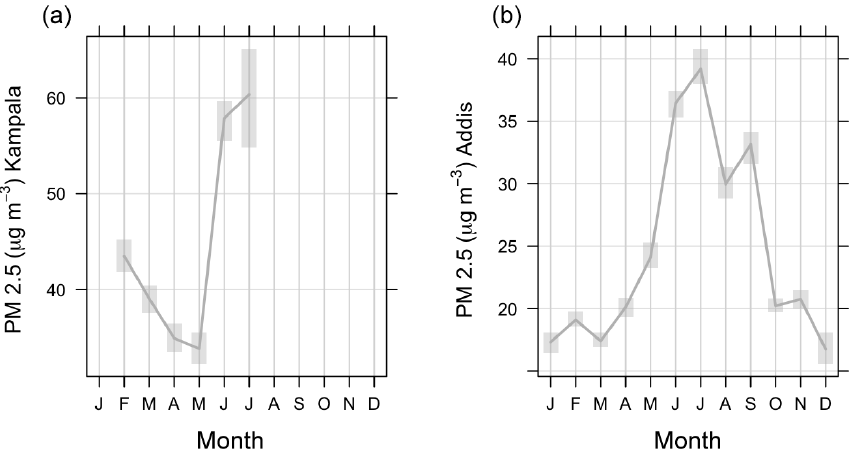
Figure 11. Monthly means of PM 2 . 5 concentrations measured at the US embassies in (a) Kampala, Uganda, (as available) and (b) Addis Ababa, Ethiopia, (b) from January–December 2016/2017 (as available). Shaded areas are 95% confidence intervals. Lines indicate daily average WHO recommendation for healthy PM 2 . 5